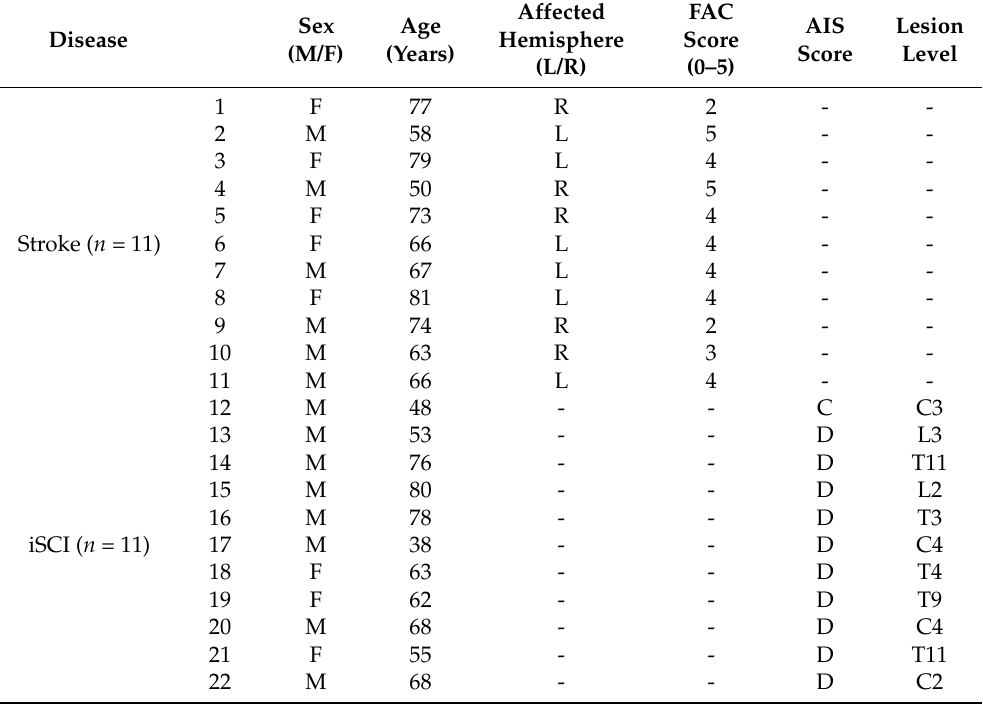
Table 2. Individual demographic and clinical characteristics of the